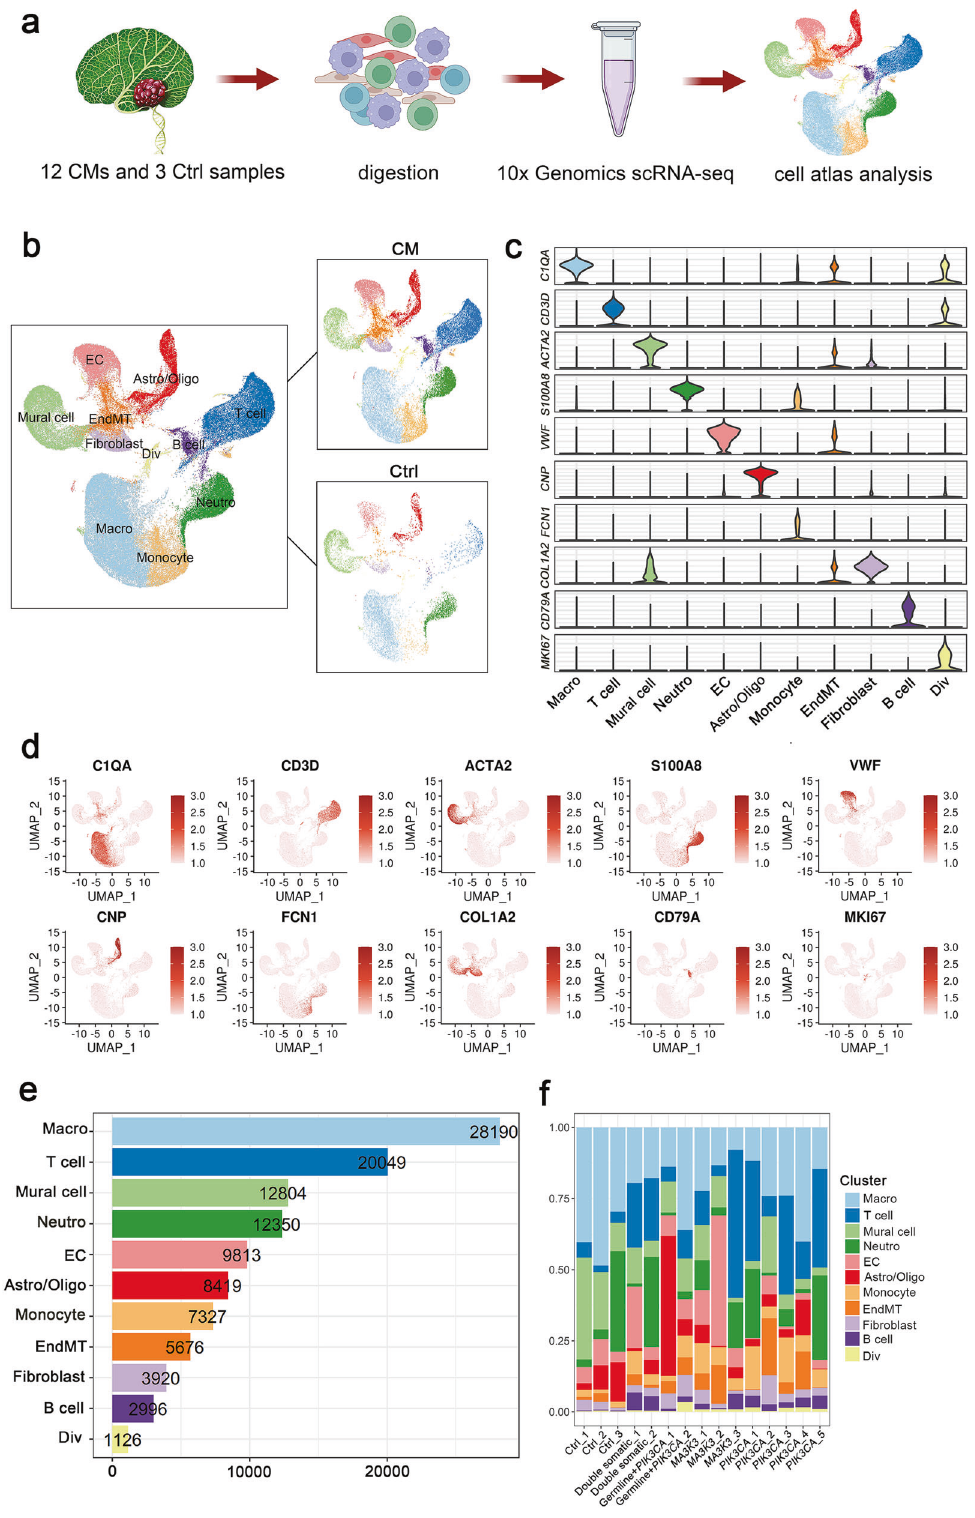
Fig. 1 Cellular atlas of CM and control samples. a Schematic diagram of the scRNA-seq analysis work fl ow. Twelve CM and three control tissue samples were digested into single cells and sequenced using the 10x Genomics platform. b Uniform manifold approximation and projection (UMAP) plot for eleven cell types of 112670 high-quality single cells in control and CM samples. Marker genes for 11 distinct cell types shown in ( c ) violin plots and ( d ) UMAP feature plots. e Cell numbers of eleven cell types. f The proportion of all eleven cell types in samples. Macro macrophage, Neutro neutrophil, EC endothelial cell, Astro/Oligo astrocyte/oligodendrocyte, EndMT endothelial-to- mesenchymal transition, Div dividing immune